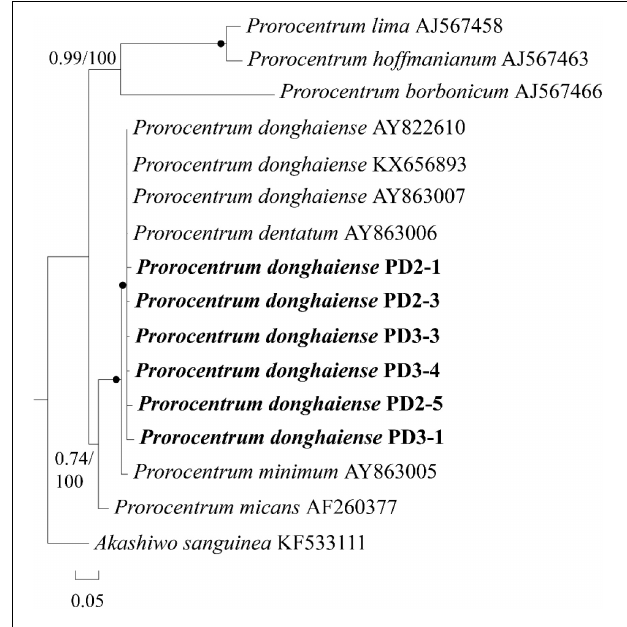
FIGURE 6 | A phylogenetic tree of Prorocentrum donghaiense inferred from partial LSU rRNA gene sequences using Bayesian inference. The two sequences PD-2 and PD-3 were obtained via sing-cell PCR sequencing for the resting cysts that had been detected with FISH from sediment. Numbers on branches are statistical support values [ left , Bayesian posterior probabilities; right , maximum likelihood (ML) bootstrap support values]. Bootstrap values > 50% and posterior probabilities (pp) above 0.5 are shown. Black circles ( • ) indicate maximal support (pp = 1.00 in BI and bootstrap support = 100% in ML, respectively). All branches are drawn to scale.